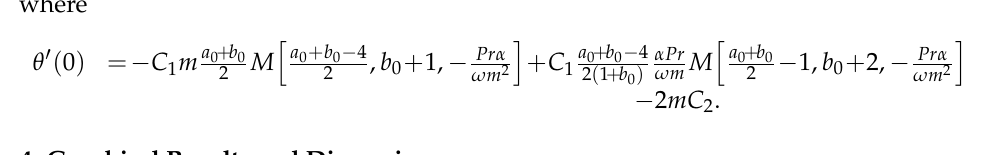
Table 2. Comparison solutions for − F (cid:48)(cid:48) ( 0 ) (skin friction coefficient). When φ Fe φ Cu